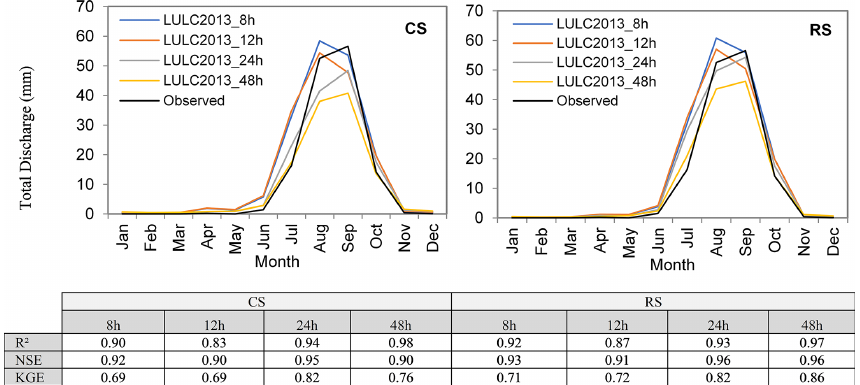
Figure 3. Model performance using different modeling time steps and soil parameterization approaches. Period of January 2013 to Decem- ber 2014. Performance is calculated using mean monthly